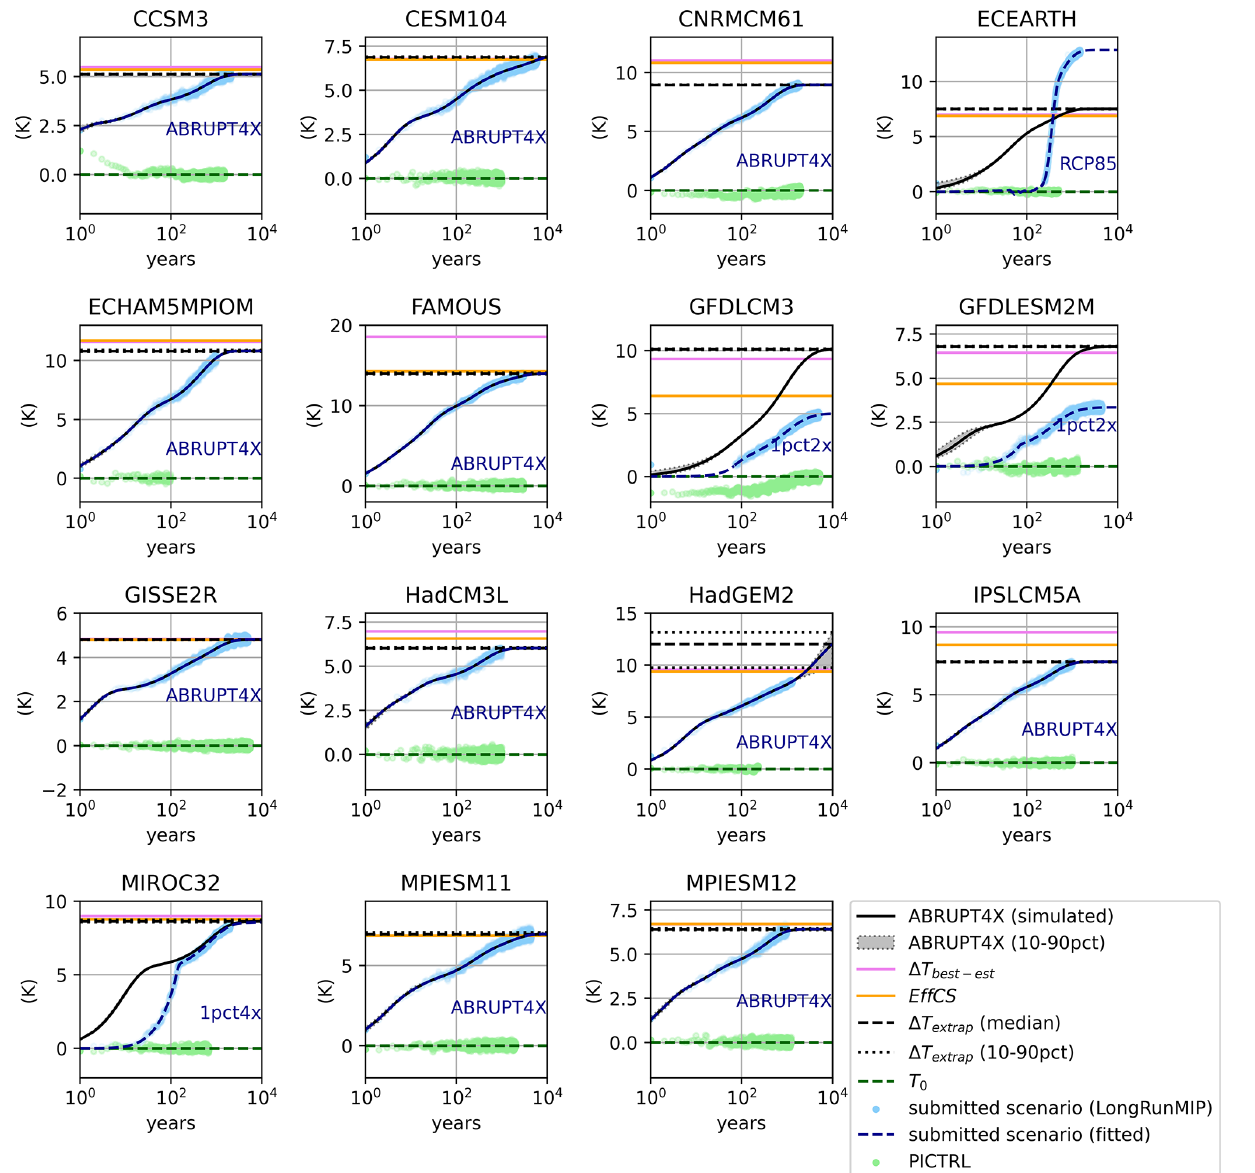
Figure 4. Global mean temperature anomaly with respect to the last 500 available years of the PICTRL simulation, plotted as a function of time (log scale) for the members of the LongRunMIP ensemble. Green points show annual global mean surface temperature anomalies from the LongRunMIP PICTRL simulation, while blue points show data from the submitted climate change experiment (printed in blue text for each model). Thick blue lines show the median top-of-atmosphere time series using the MCMC posterior fit for the multi-timescale model selected to represent the corresponding ESM (see Sect. 2 and Fig. 1). Black lines show the median response of the fitted multi-timescale model to an ABRUPT4X forcing, while shaded gray regions and thin dotted lines show the 10th and 90th percentiles of the fitted ABRUPT4X ensemble projections. Dashed black horizontal line illustrates (cid:49)T extrap (median), yellow solid line is EffCS, pink solid is (cid:49)T best − est and dashed green line shows T 0 . Readers should note y axis differs by